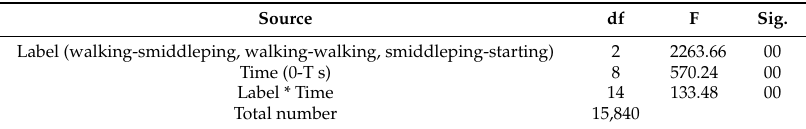
Figure 10. Distance between pedestrians and zebra crossings under different crossing intentions. ( a ) Distance between pedestrians and zebra crossings at different times and with different intentions. ( b ) Mean distance between pedestrians and zebra crossings under different crossing intentions. Table 9. Main effect test table.